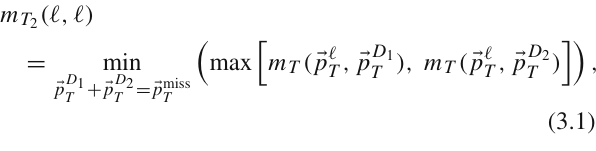
tails for which is much flatter than that of t ¯ t